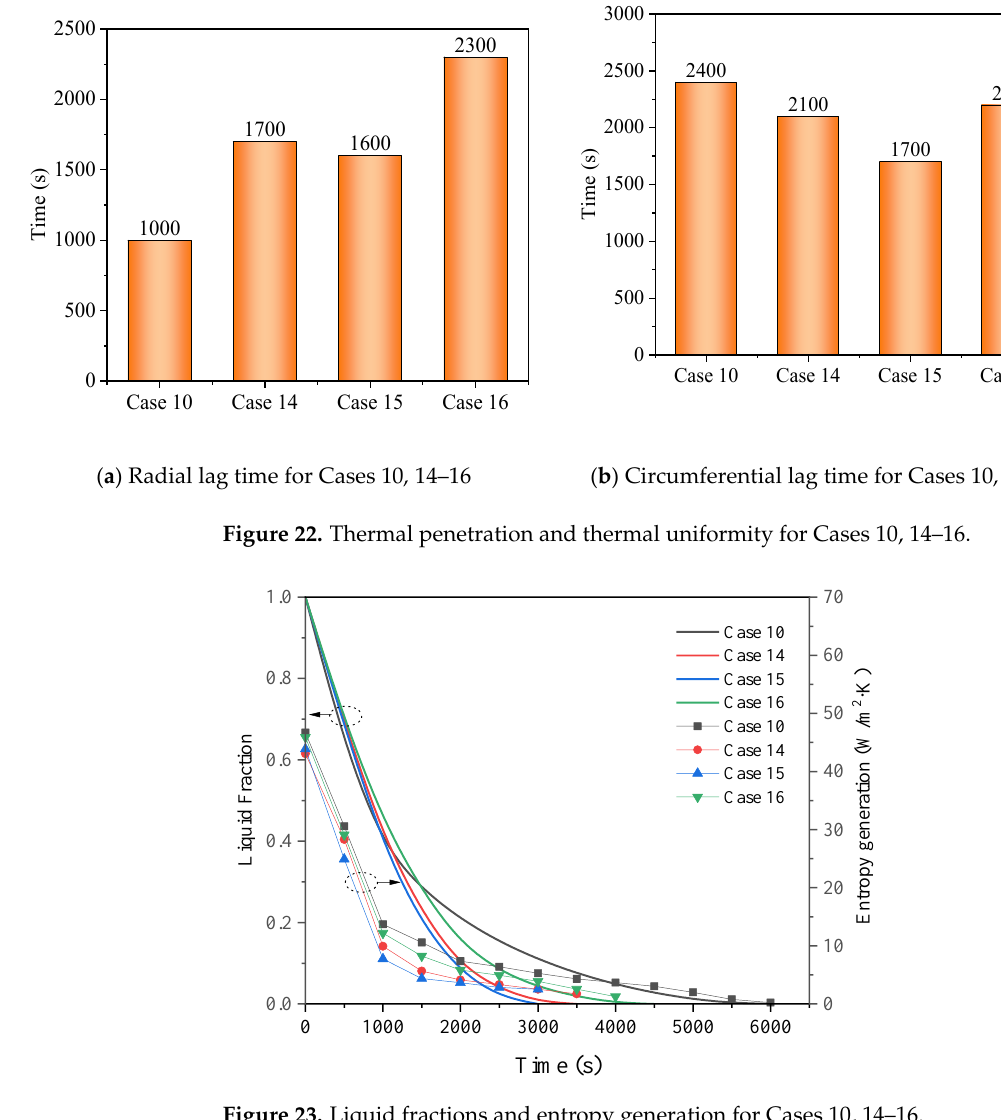
Figure 2. Time-step and mesh-size tests. ( a ) Time step and ( b ) mesh size.